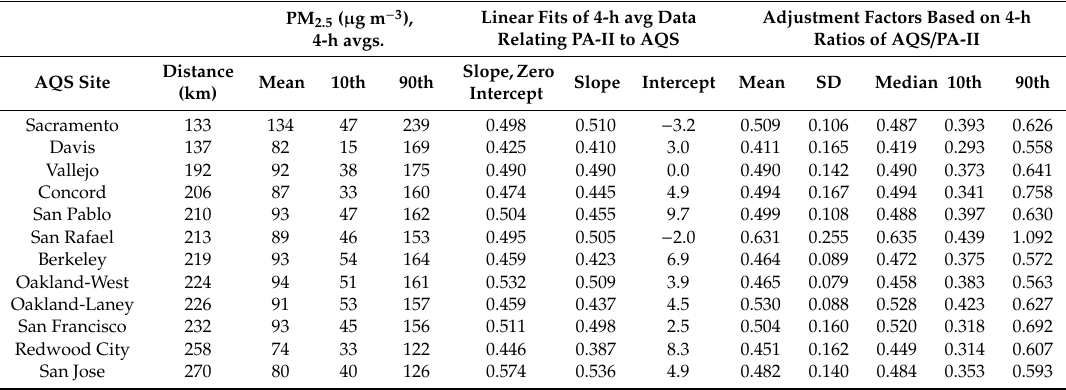
Table 2. Calculated linear fitting parameters with / out a zero o ff set and adjustment factors to quantify